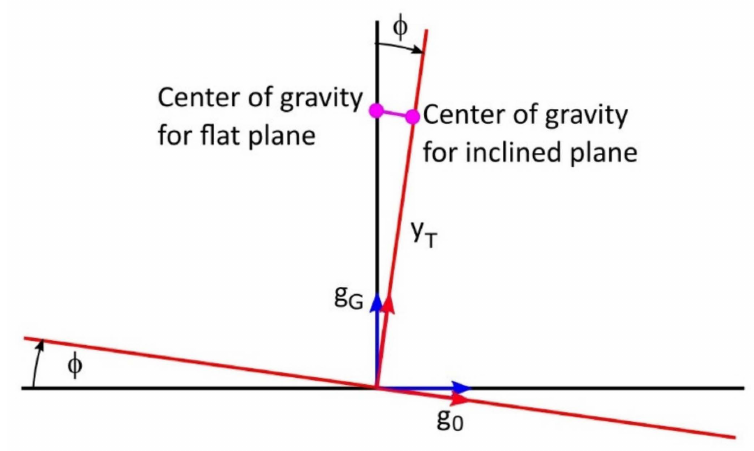
Figure 6. Necessary shift of the center of gravity to maintain the stability of the